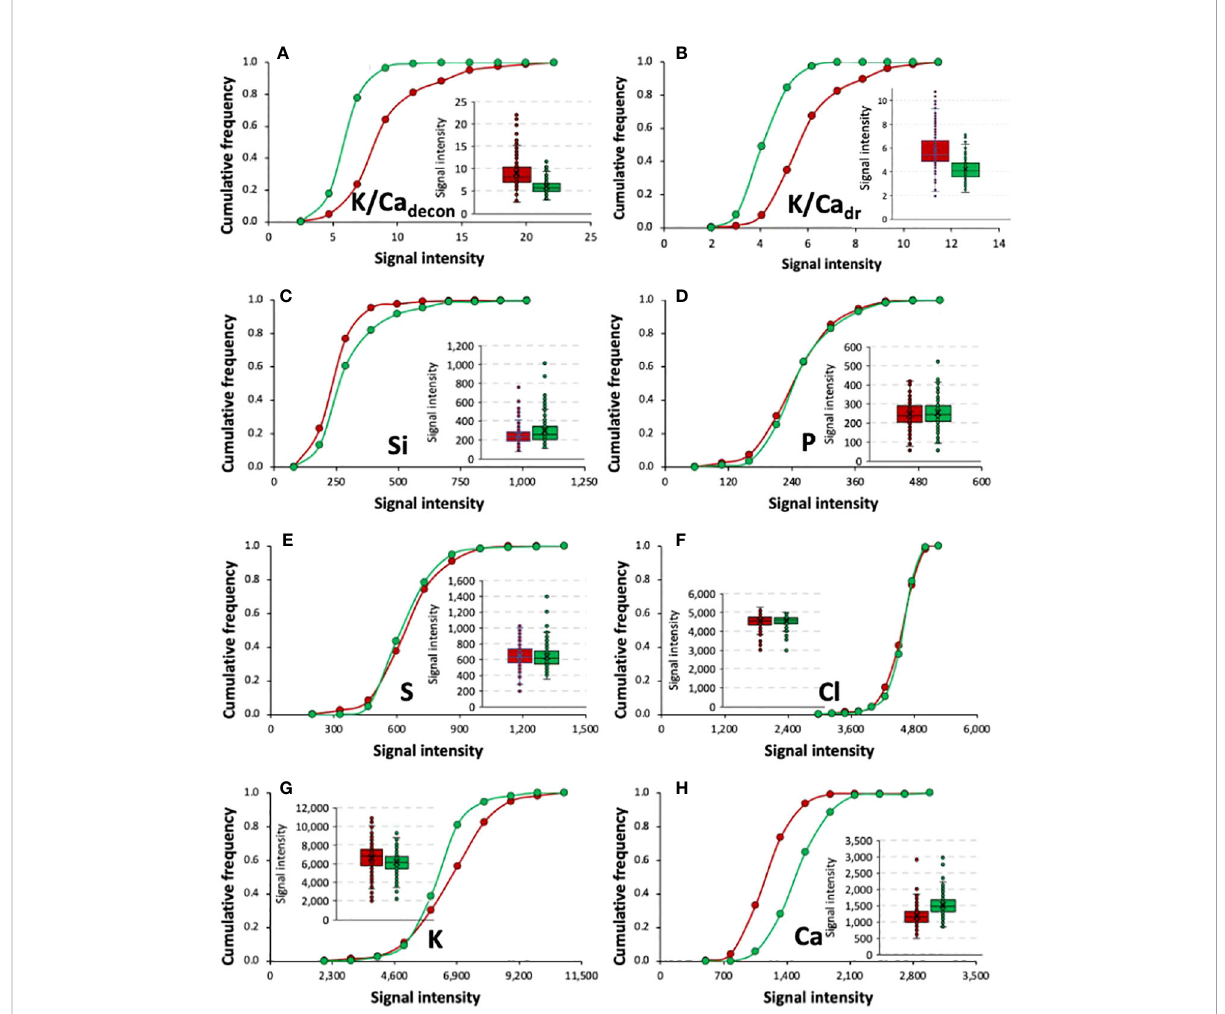
FIGURE 4 Comparison of the cumulative frequency distributions and box-and-whisker plots of K/Ca ratio calculated by the deconvolution method (decon) (A) and direct ratio (dr) (B) from maximum K and Ca signals, and the signal insensitivity of the mineral elements with the greatest preponderance in ‘ Granny Smith ’ fruit with (red) or without (green) bitter pit: Si (C) , P (D) , S (E) , Cl (F) , K (G) , and Ca (H) .